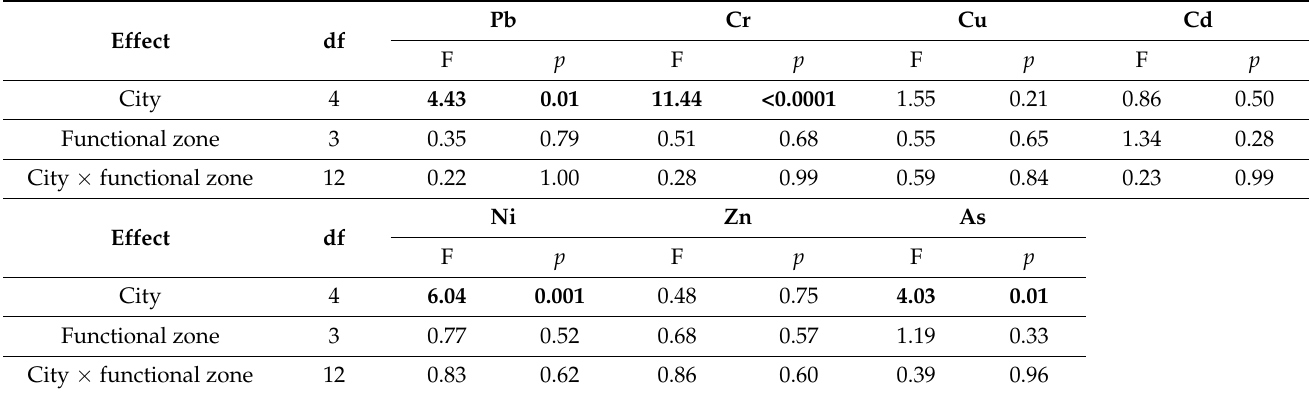
Table 5. MANOVA univariate results for each dependent variable.